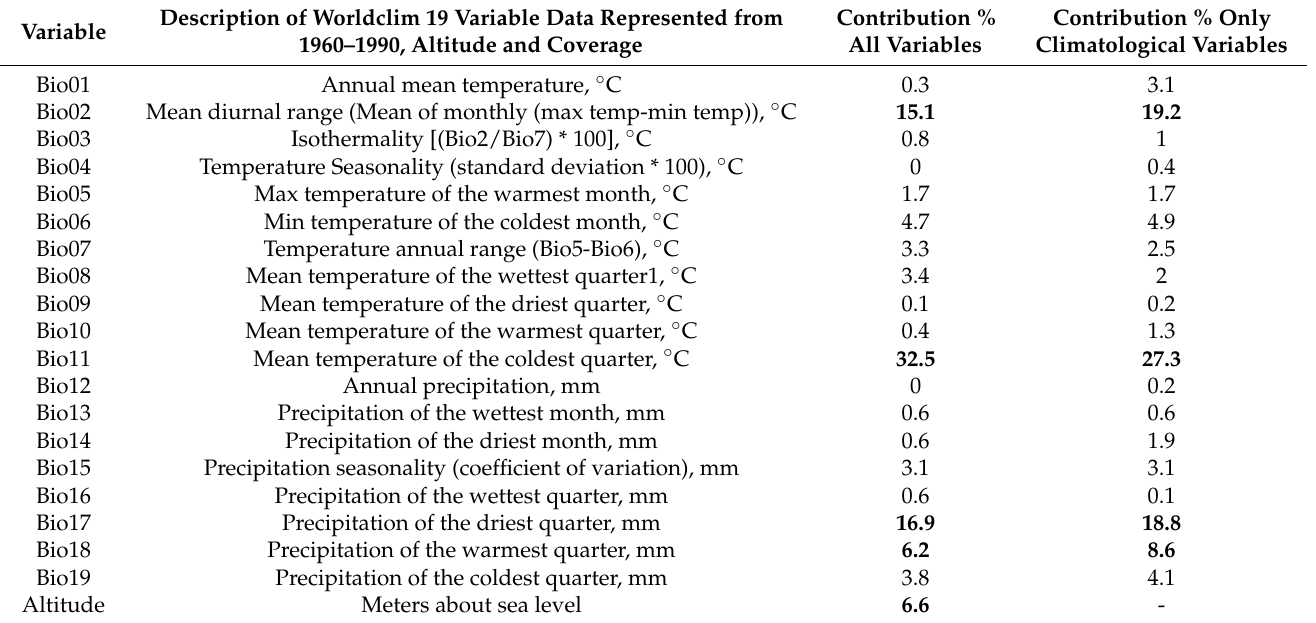
Table 1. Worldclim 19 variables description plus